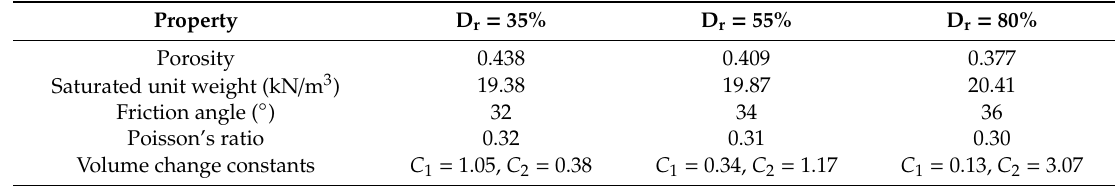
Table 1. Input properties of the model soil used in numerical analysis.